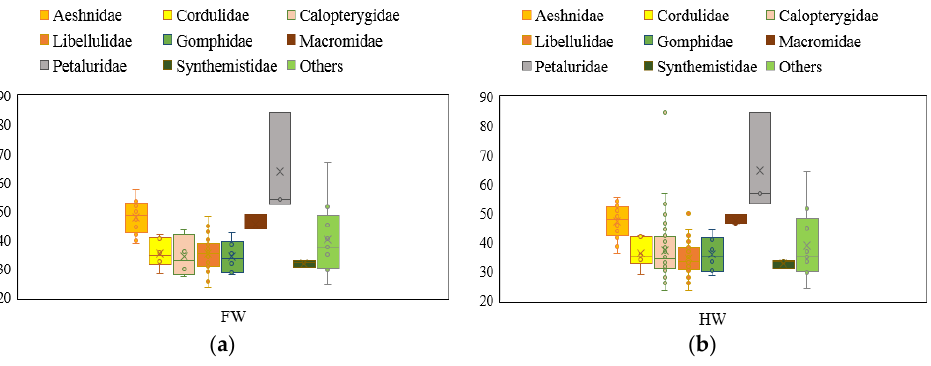
Figure 5. Semi-span distribution for both FW ( a ) and HW ( b ).